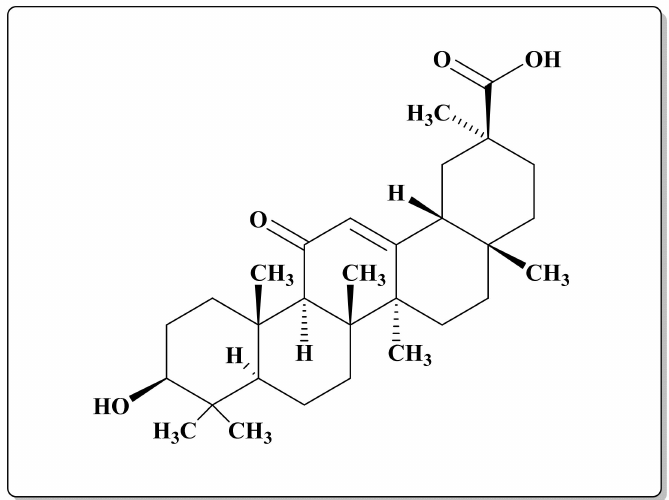
Figure 1. Chemical structure of 18 β -glycyrrhetinic acid